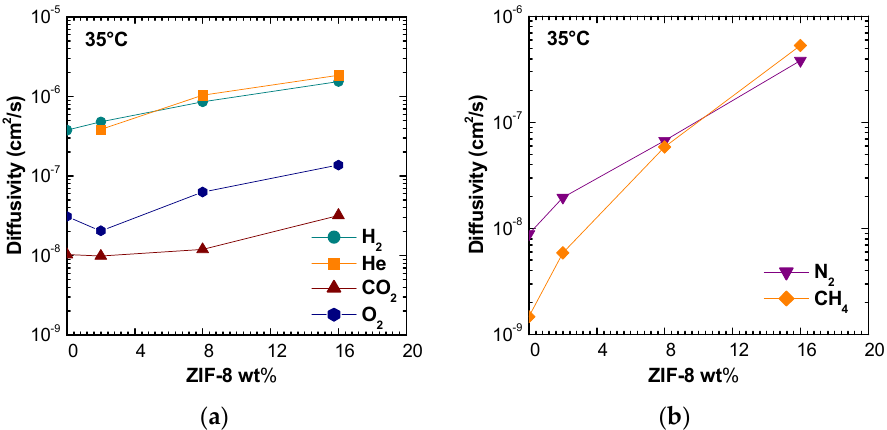
Figure 9. Diffusivity of various gases in PSf/ZIF-8 mixed matrix membranes as a function of ZIF-8 wt%: ( a , b ) at 35 °C. The behavior at 50 and 65 °C is reported in Figure S3.